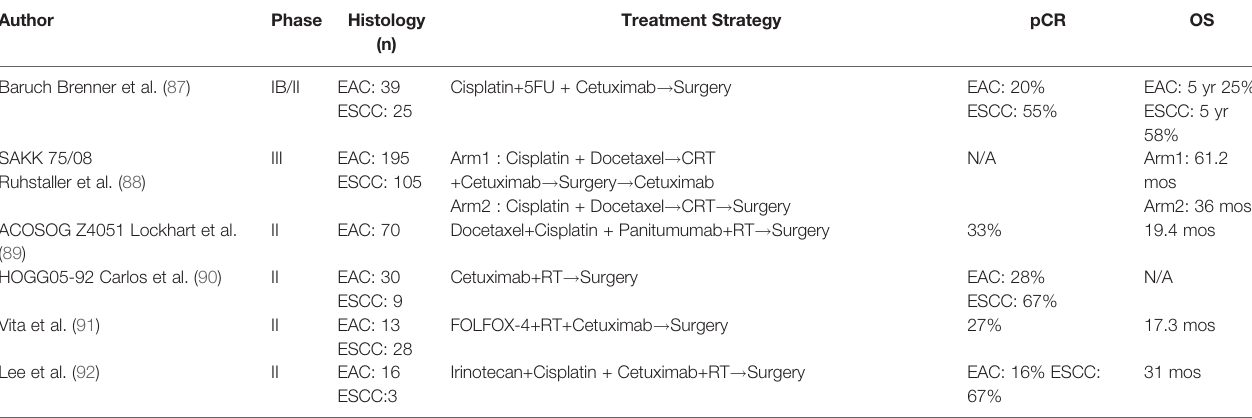
TABLE 2 | Summary of studies using anti-EGFR monoclonal antibodies with chemoradiation for resectable locally advanced esophageal cancer.